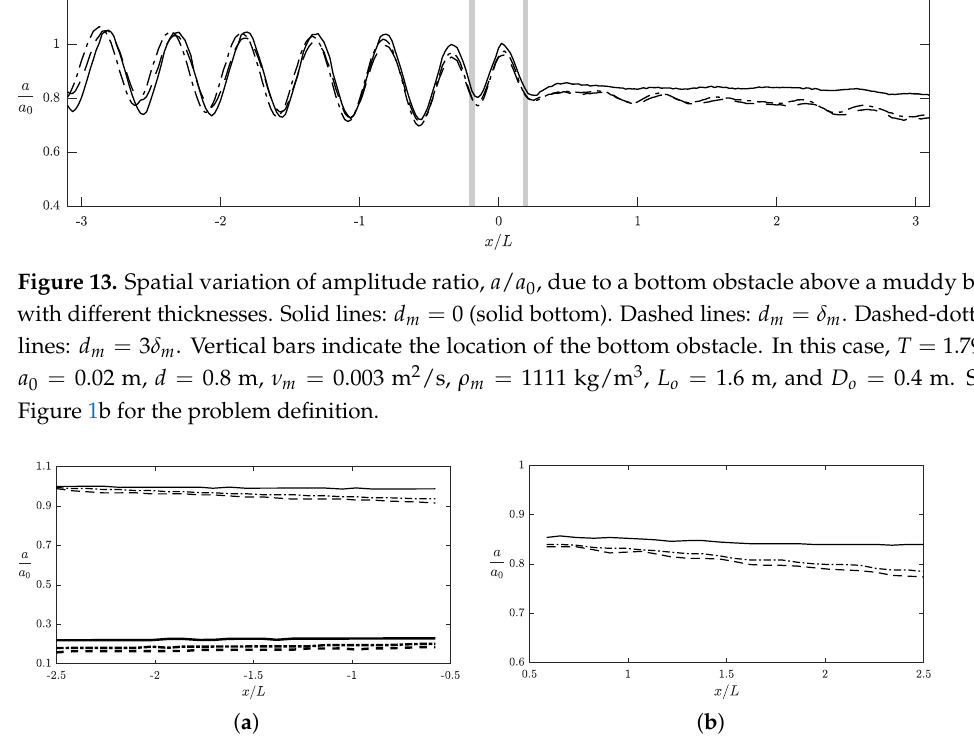
Figure 14. Wave components corresponding to the case of a bottom obstacle shown in Figure 13: ( a ) incident waves (thin lines) and reflected components (thick lines); ( b ) transmitted waves. Solid lines: d m = 0 (solid bottom). Dashed lines: d m = δ m . Dashed-dotted lines: d m = 3 δ m . Vertical bars indicate the location of the bottom obstacle. See Figure 13 for the model